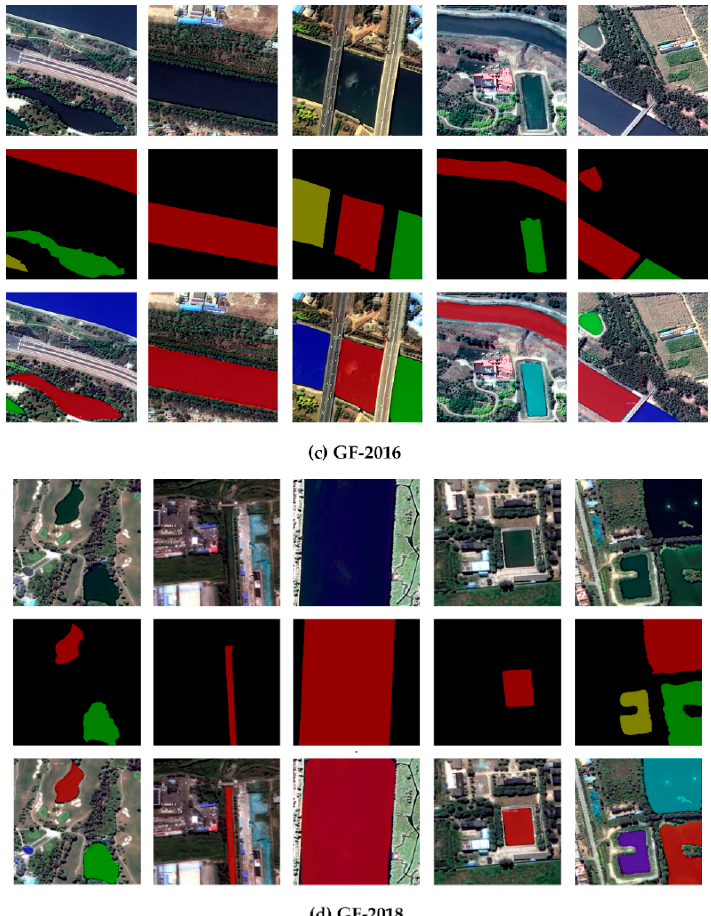
Figure 13. Examples of water recognition results of the Mask R-CNN model trained by WV-2014 ( a ), WV-2017 ( b ), GF-2016 ( c ) and GF-2018 ( d ) datasets. From top to bottom: image, label, water recognition results. From left to right: water body recognition results based on different morphological characteristics of corresponding data sets. Table 7. Water recognition accuracy of the Mask R-CNN model trained with four different datasets at the object levels in four different test area. Training Test Actual Prediction Match Precision Recall